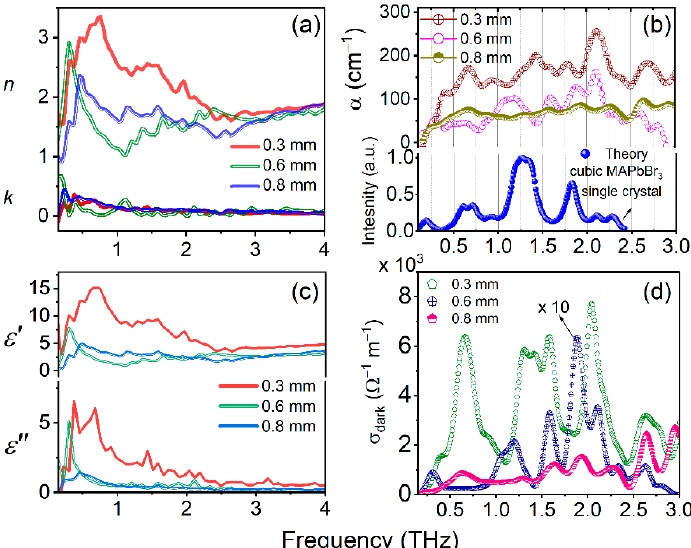
Figure 10. ( a ) Real refractive index (n), imaginary refractive index (k); ( b ) absorption coefficient ( α ), bottom panel theoretically calculated IR spectrum for cubic MAPbBr 3 single crystal (data adapted from Ref. [19], with permission from Springer nature). ( c ) Real dielectric constant ( ε ’), imaginary dielectric constant ( ε ”), and ( d ) dark conductivity of various-thickness MAPbBr 3 PSCs measured based on THZ -TDS.